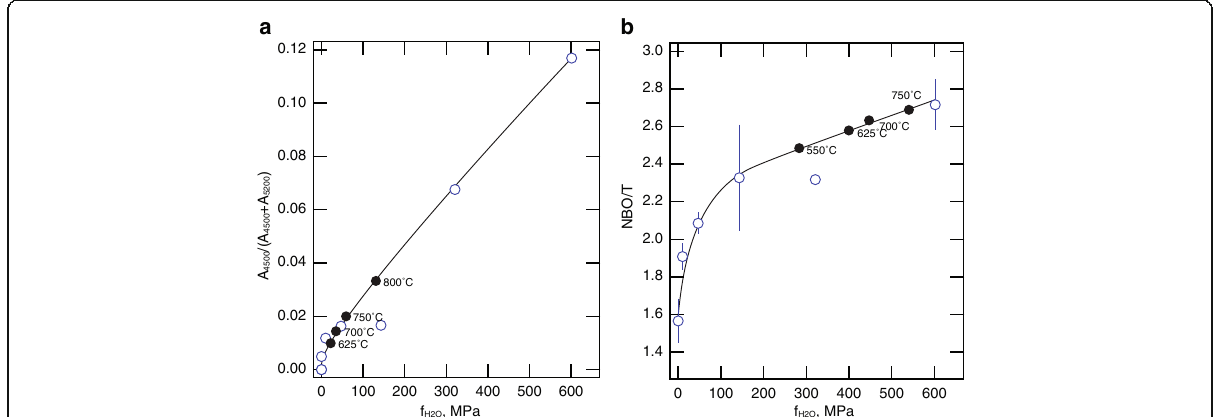
Fig. 12 Relationship between fugacity of H 2 O, f H2O , and species abundance. a Proportion of OH and molecular H 2 O as a function of f H2O in NA10 – H 2 O fluid from Mysen (2010) (open symbols). Solid symbols plotted onto the line are the date from the current silicate – C – O – H – N fluid. In both cases, the silicate starting composition is NA10. See text for discussion of approximation of OH/(OH+H 2 O) ratio with the FTIR absorbance ratio, A 4500 /( A 4500 + A 5200 ). Silicate polymerization of melt, NBO/T, as a function of f H2O in NA10 – H 2 O fluid from Mysen (2010) (open symbols). b Evolution of NBO/T of the silicate component in the fluid as a function of temperature. Solid symbols plotted onto the line are the data from the current silicate – C – O – H – N fluid. In both cases, the silicate starting composition is NA10